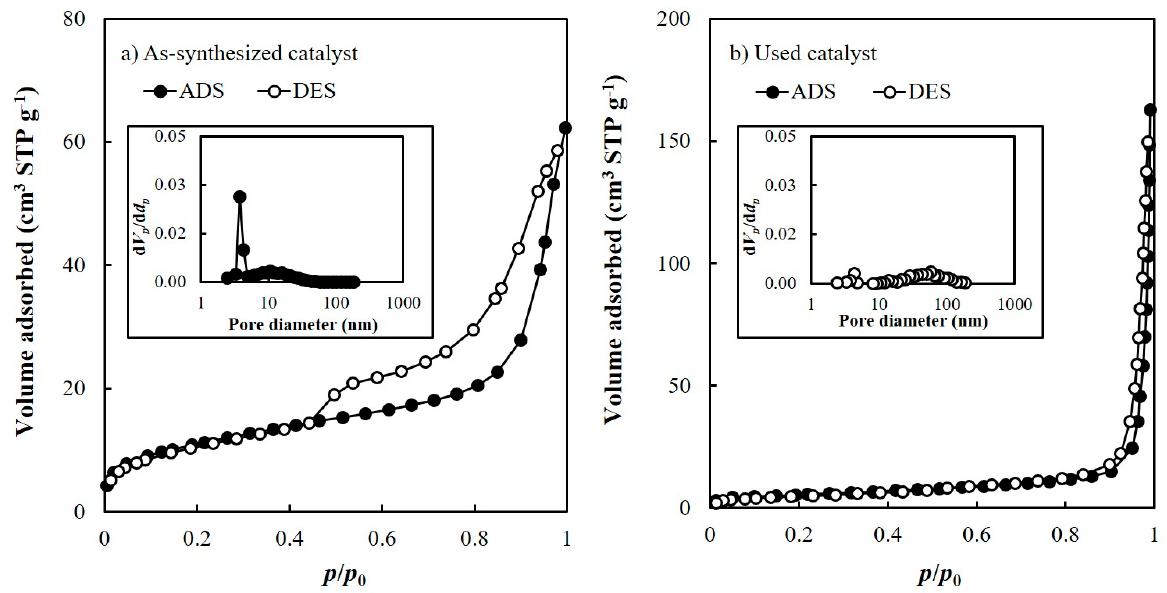
Figure 2. Nitrogen adsorption–desorption isotherms: ( a ) As-synthesized catalyst, ( b ) Used catalyst. The insets in figures present the pore size distribution among as-synthesized and used Cs/Ru/MgO catalysts.